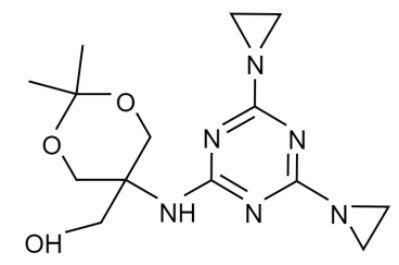
Figure 1. Chemical structure of [5-[[4,6-bis(aziridin-1-yl)-1,3,5-triazin-2-yl]amino]-2,2-dimethyl-1,3-dioxan-5-yl]methanol (dioxadet, DOD).